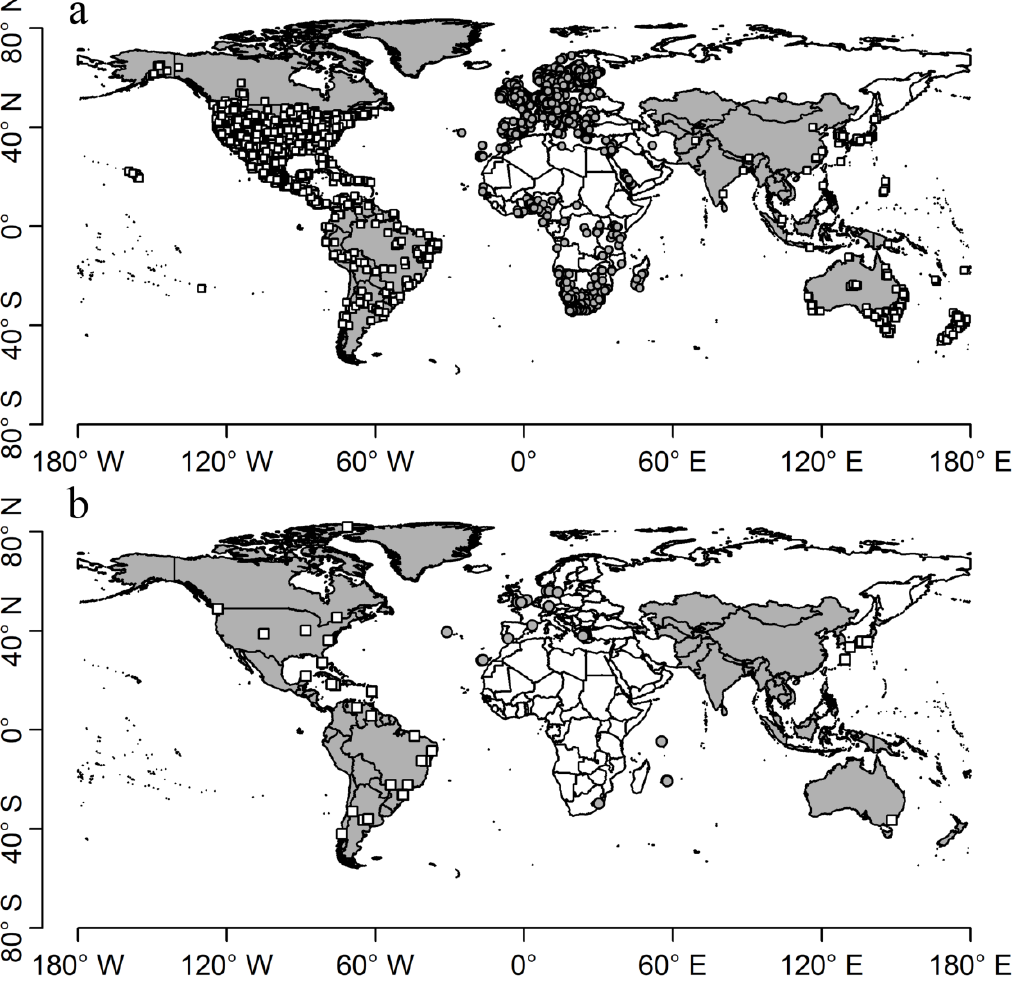
Fig 1 . World map with the geographic distribution of the Apis mellifera Linnaeus, 1758 dataset. Areas in grey denote exotic distribution, and white areas denote native distribution. Exotic occurrences are indicated by white squares, and native occurrences are indicated by grey circles (a). White squares indicate networks in which A . mellifera is exotic, while grey circles indicate networks in which A . mellifera is native